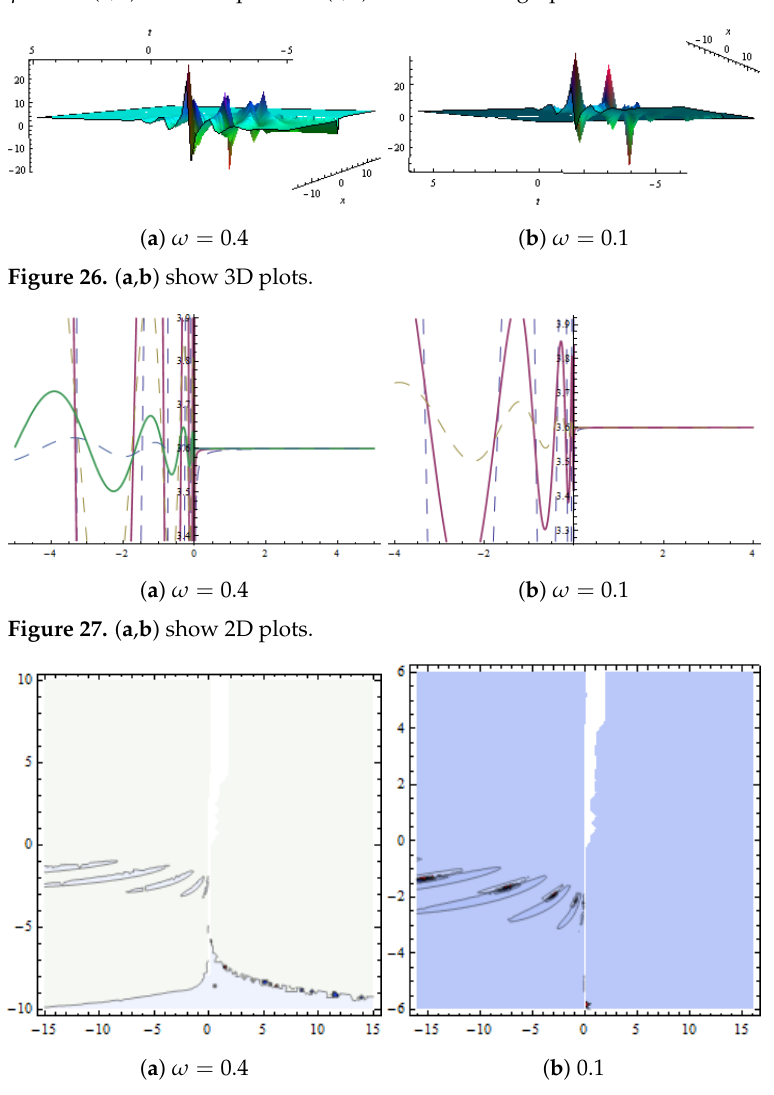
Figure 28. Dynamical presentation of solution v ( x , t ) in Equation (63) with β 2 = 0.2, β 3 = 3.5, ζ = 0, l 1 = 0.03, l 2 = 0.01, l 4 = 2, Q = 5, r 1 = 4.5, r 2 = 2.1, w 2 = 0.1, w 3 = 4.3, w 4 = 1.9 and φ = 1.2. ( a , b ) show contour